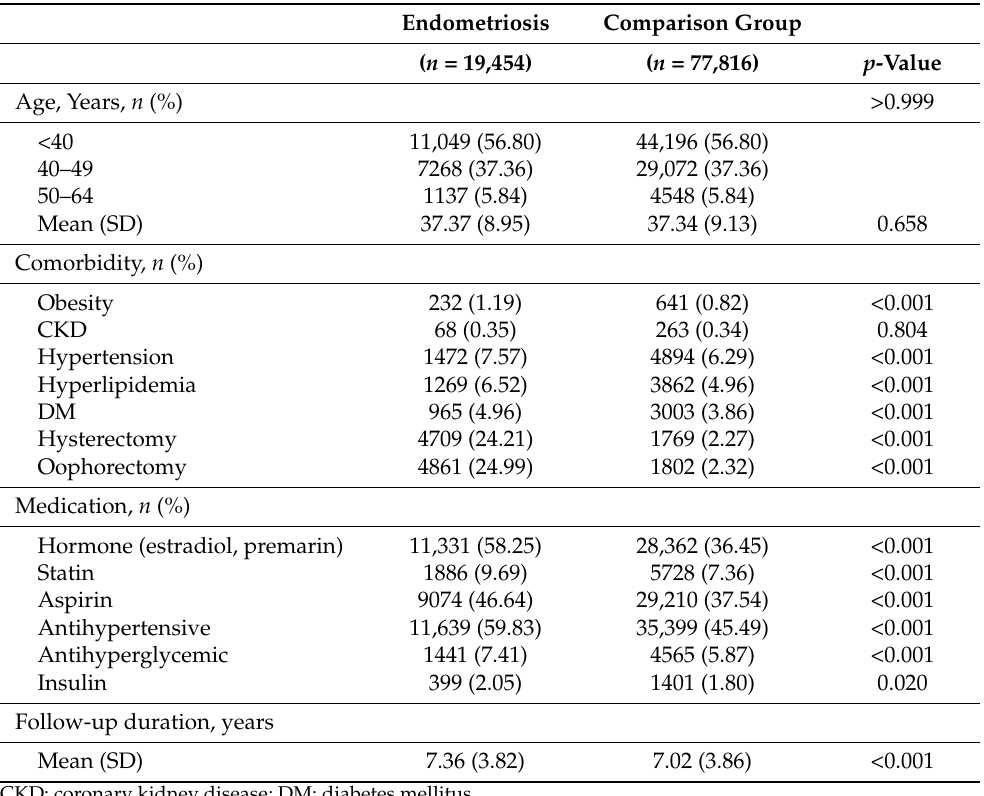
Table 1. Baseline characteristics of the women in the endometriosis and comparison